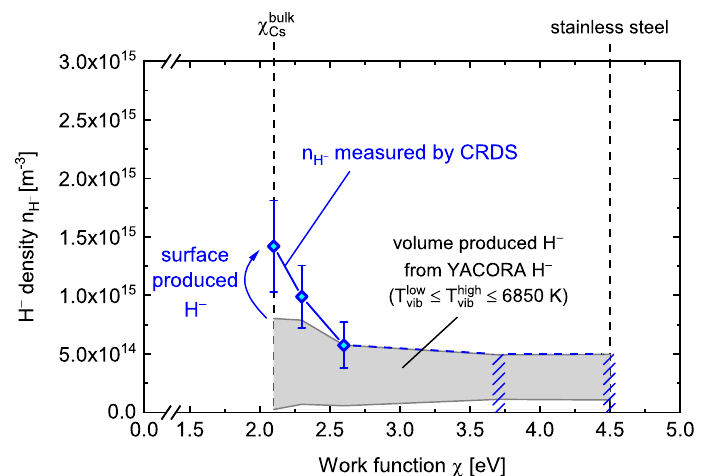
Figure 3. Negative hydrogen ion and electron densities measured for different work functions in a hydrogen plasma at 2 Pa and 450 W. The measurements are taken at 2 cm and 8 mm from the sample surface, respectively.